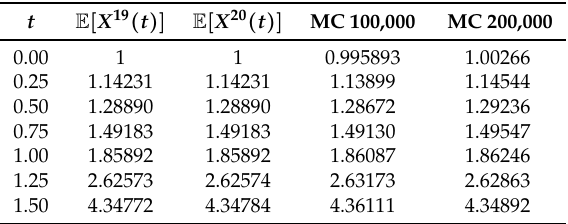
Table 1. Approximation of E [ X ( t )] with N = 19, N = 20, and Monte Carlo simulations. Example 5.